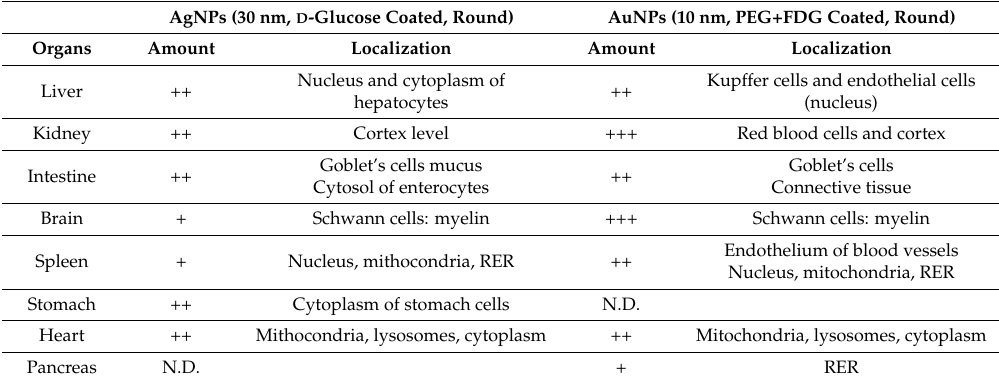
Table 1. Semiquantitative analysis of the biodistribution, as amount and localization, of AgNPs and AuNPs after injection in mouse tail vein of 10 8 NPs performed by transmission electron microscope.